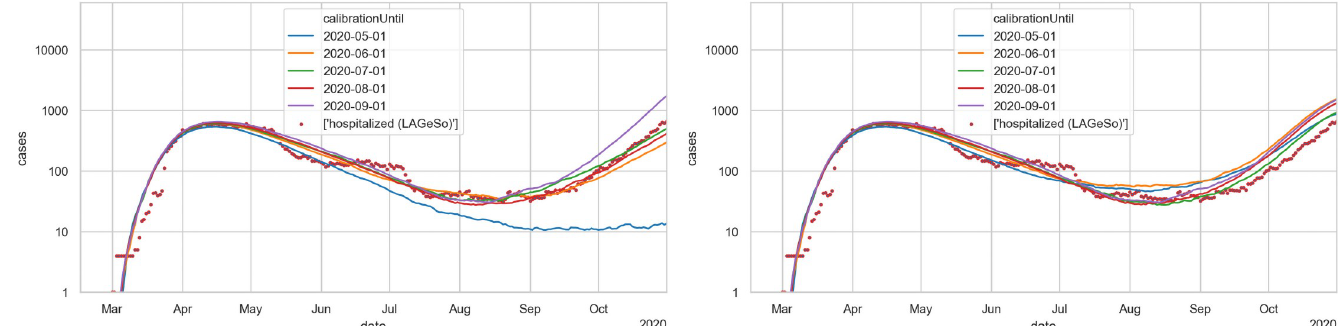
Fig 17. Hospitalized persons for different calibration runs compared to real data. Θ is calibrated such that hospital numbers in the simulation match the real data (red dots) until different points in time as indicated by the legend. After this date, an out of sample prediction is carried out. Until the calibration date real weather and disease import data is used. After the calibration date average weather data from the past ten years is used and the disease import is set to 4 imported cases per day (1 agent per day) LEFT: Activity levels are frozen at the level of the last day of the period used for calibration. RIGHT: Real activity levels are used.—Results are averaged over 30 Monte Carlo seeds.